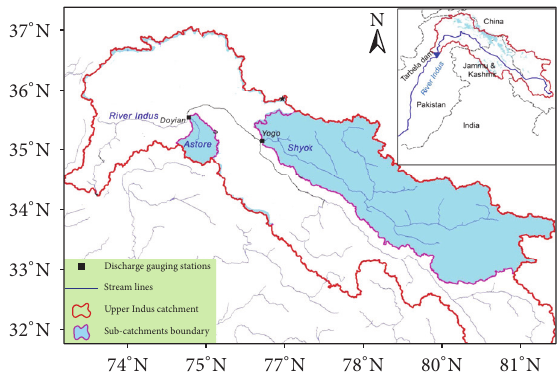
Figure 3: The location map of the Astore and Shyok